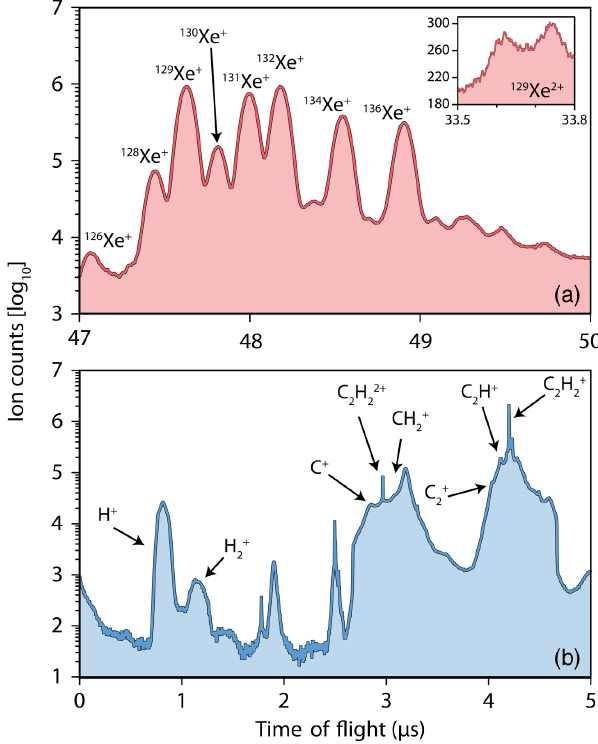
FIG. 6. (a) The measured ion TOF spectrum after the ionization of Xe using the 3 . 1 - μ m output. The individual Xe isotopes can be ~E j ~B j accurately resolved when low j and j extraction fields are used. The inset shows TOF information corresponding to 129 Xe 2 þ . (b) The same as in (a) except for C 2 H 2 and with high extraction fields. Many molecular fragments are observed with each one having its own corresponding